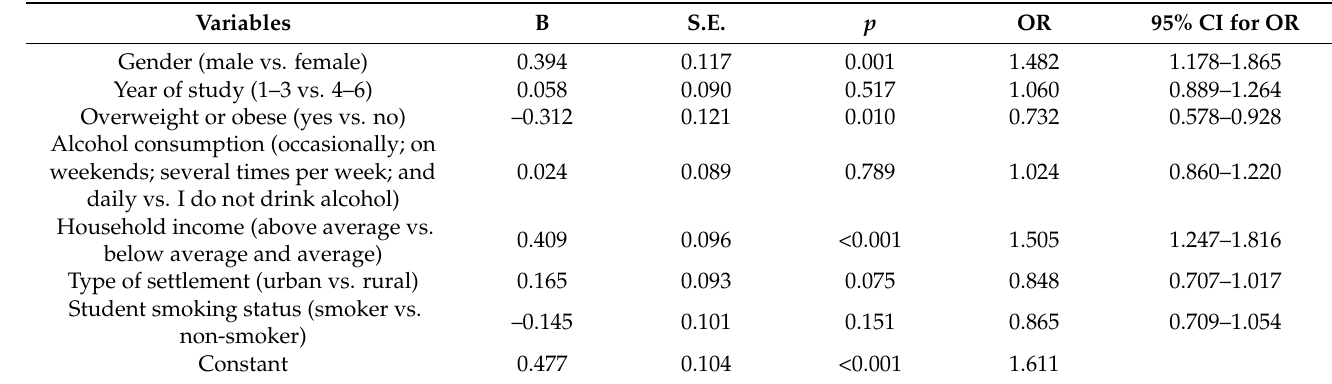
Table 7. Association between independent variables and physical activity of medical